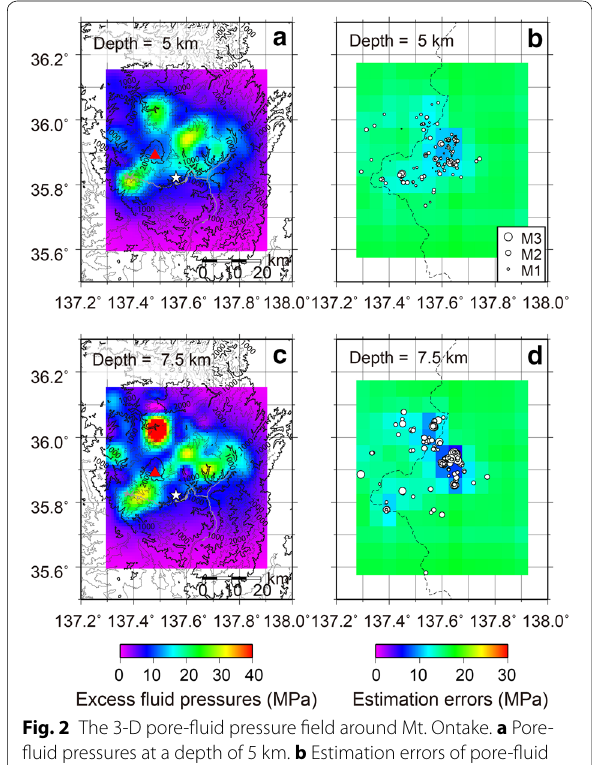
Fig. 2 The 3-D pore-fluid pressure field around Mt. Ontake. a Pore- fluid pressures at a depth of 5 km. b Estimation errors of pore-fluid pressures at a depth of 5 km. c Pore-fluid pressures at a depth of 7.5 km. d Estimation errors of pore-fluid pressures at a depth of 7.5 km. The pore-fluid pressure fields are superposed on the topo- graphic map in ( a , c ). The white circles in ( b , d ) denote the data used in the FMT analysis within 1.25 km from the horizontal plane at 5 and 7.5 km, respectively. The red triangle and white star are the same as in Fig.